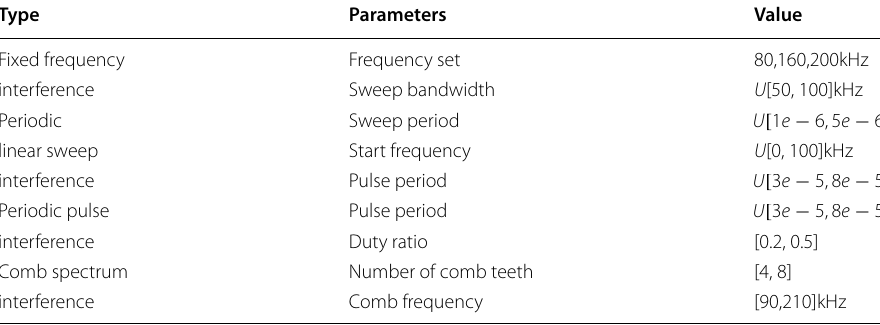
Table 3 Parameters of interference signal